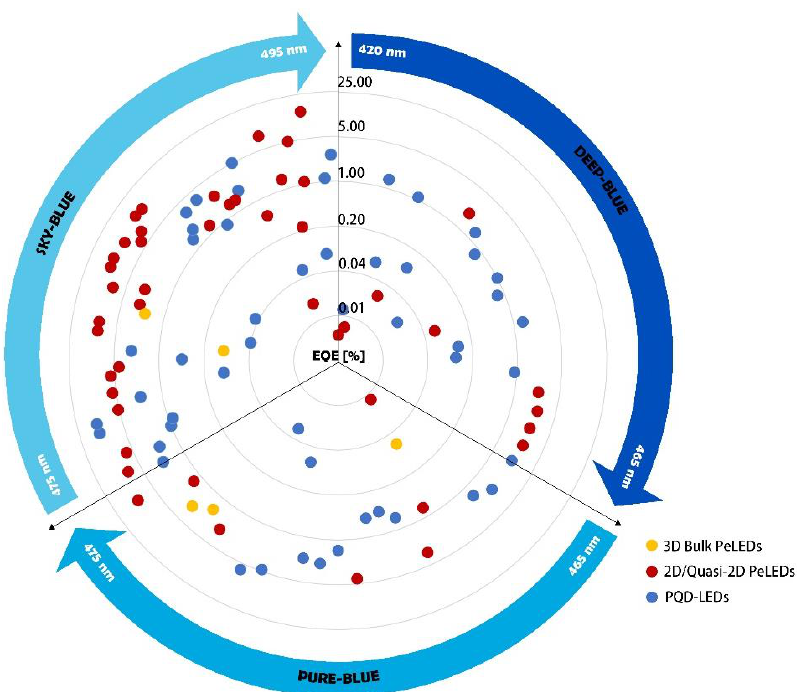
Figure 1. The distribution of EQE of some blue PeLEDs and PQD-LEDs. The division of sky-blue, pure-blue and deep-blue are based on the criteria by Rec. 2020 [1].